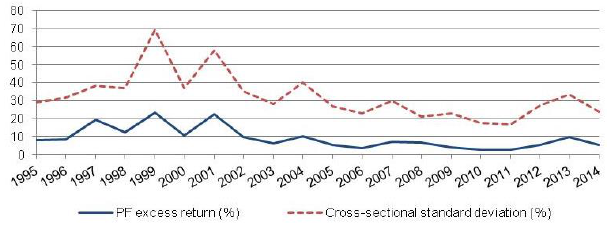
Figure 1: All share segment PF excess return and cross- sectional standard deviation